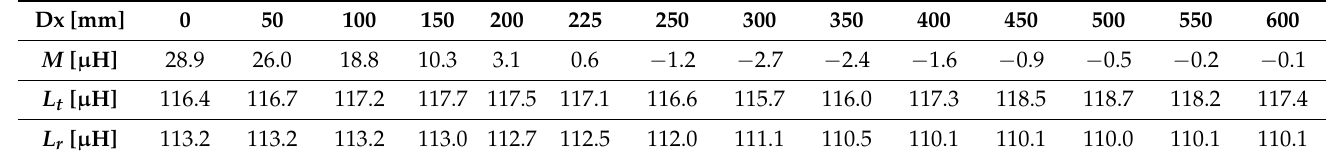
Table 2. Self and mutual-inductance for different positions. Table 2. self and mutual-inductance for different positions.